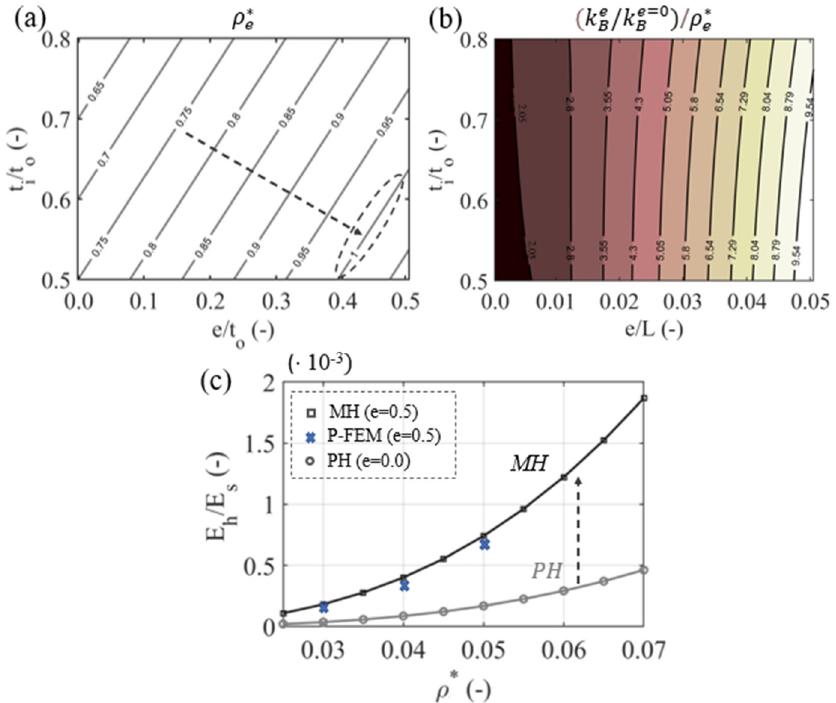
Figure 5. Dependence of the relative density of hollow variable-section elements on the swelling-to-end-element-thickness ratio e / t o and on the t i / t o ratio ( a ). The enhancement of the inner specific bending stiffness (normalized to ρ ∗ e of Equation (2) and to the prismatic bending stiffness element case) as a function of the swelling-to-length e / L and inner-to-outer-element-thickness t i / t o is provided in ( b ). A length L = 20 and a t o , t opl and t v of 1, 1 and 0.5 mm are used, respectively. The effective elastic modulus scaling with relative density for a multiscale honeycomb lattice (e = 0.5) and a prismatic honeycomb (e = 0.0) is depicted in ( c ).